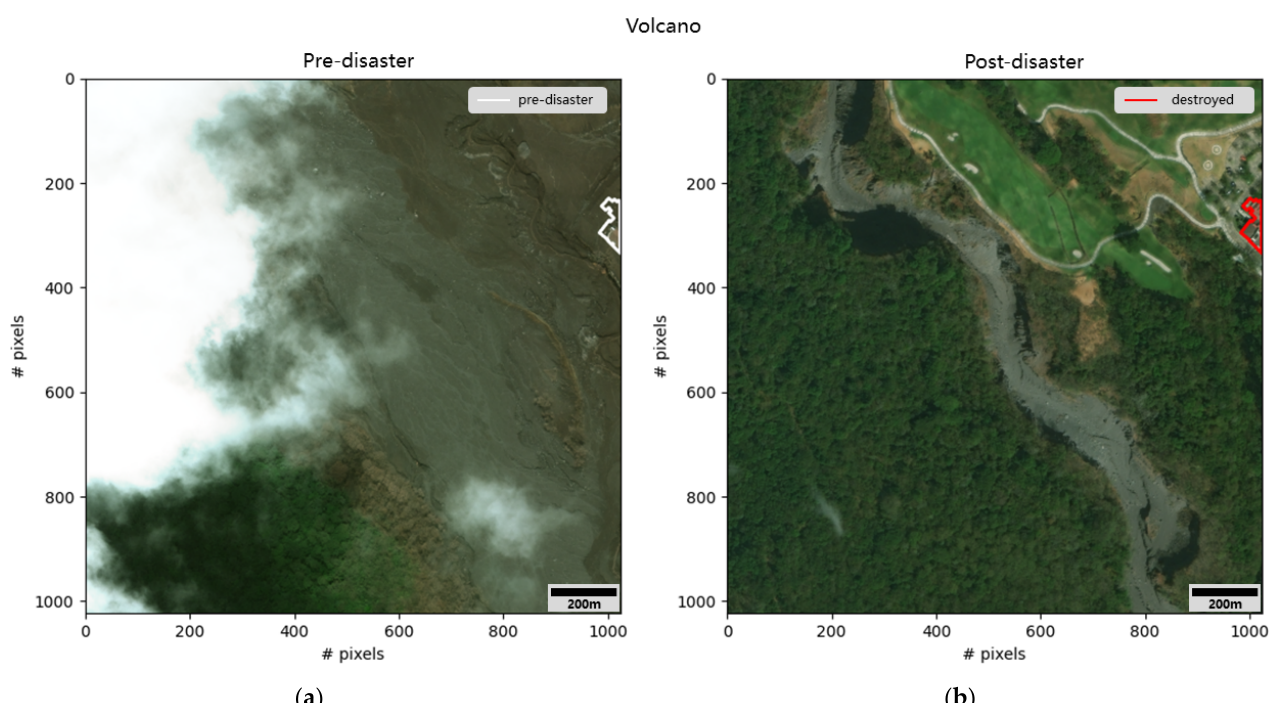
Figure 1. Example from the xBD dataset showing satellite images before and after a volcanic eruption disaster. ( a ) shows satellite imagery of buildings before the eruption and ( b ) shows satellite imagery of buildings destroyed after the eruption.